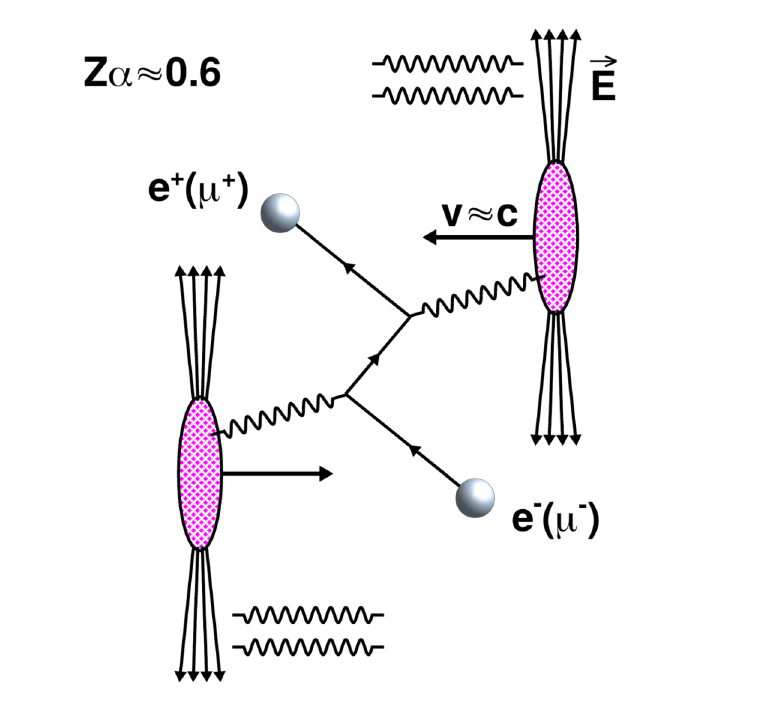
Figure 1 . (Color online) An illustration of vacuum pair production process from the strong Coulomb field of fast moving nuclei in heavy ion